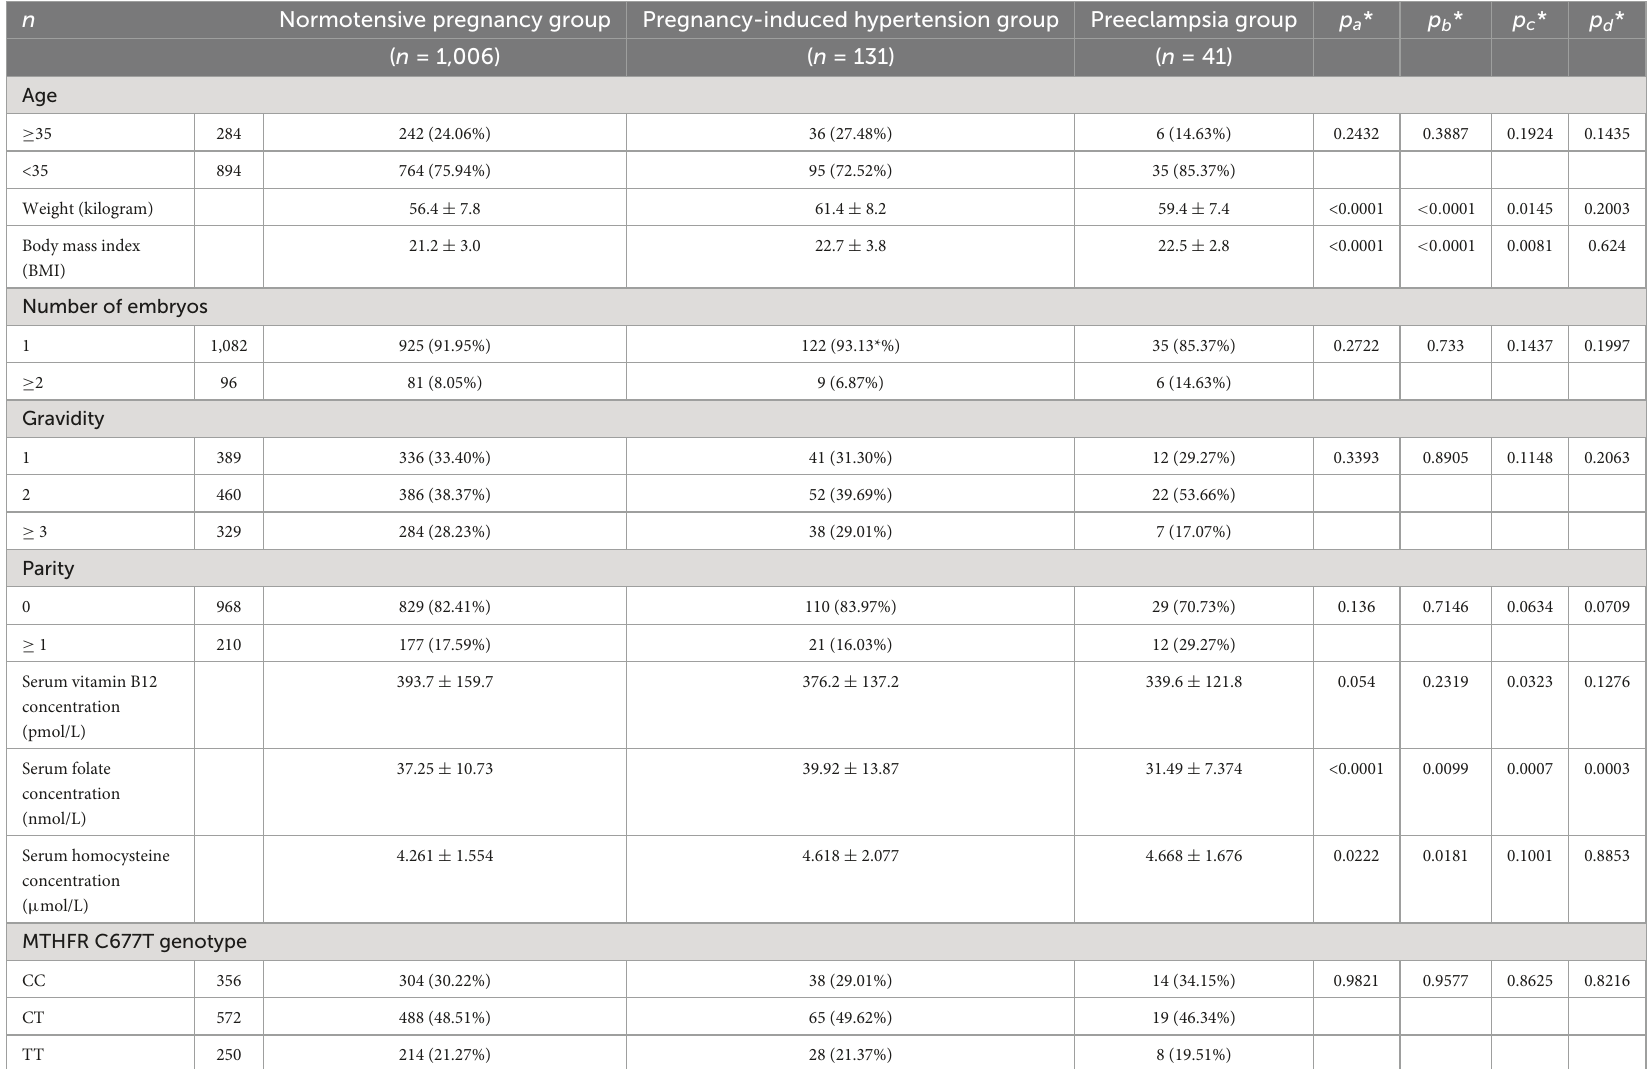
* pa: Statistical difference among the three groups. pb: Statistical difference between normal pregnancy group and pregnancy induced hypertension group. pc: Statistical difference between normal pregnancy group and preeclampsia group; pd: Statistical